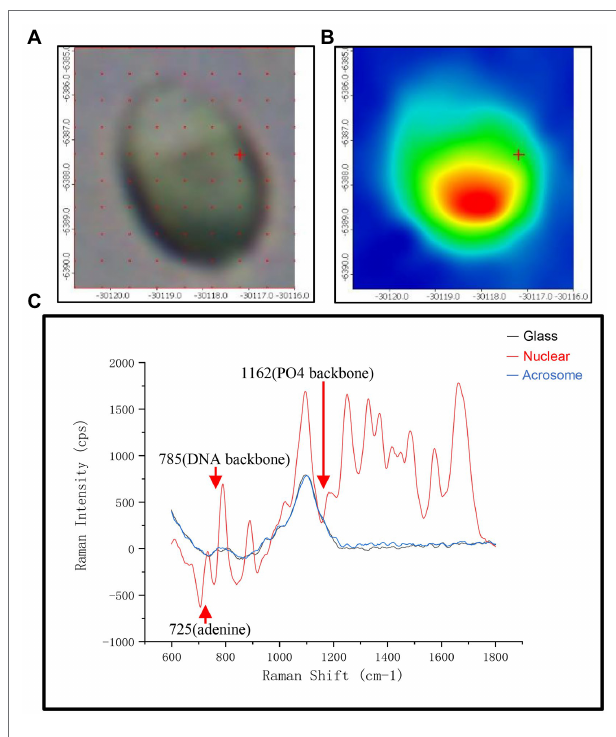
FIGURE 1 | The spectra of different regions in the sperm head. (A) Microscopic confocal picture of a human sperm cell head fixed on the glass slide. (B) The phase diagram of Raman microspectroscopy of the sperm head corresponding to (A) . (C) Raman spectra of three different positions with glass (black), acrosome (red) and DNA at the sperm head. The x-axis units are displacement wavenumber (cm − 1 ), nanometer (nm), and absolute wavenumber (cm − 1 ). The y-axis unit is generally Raman